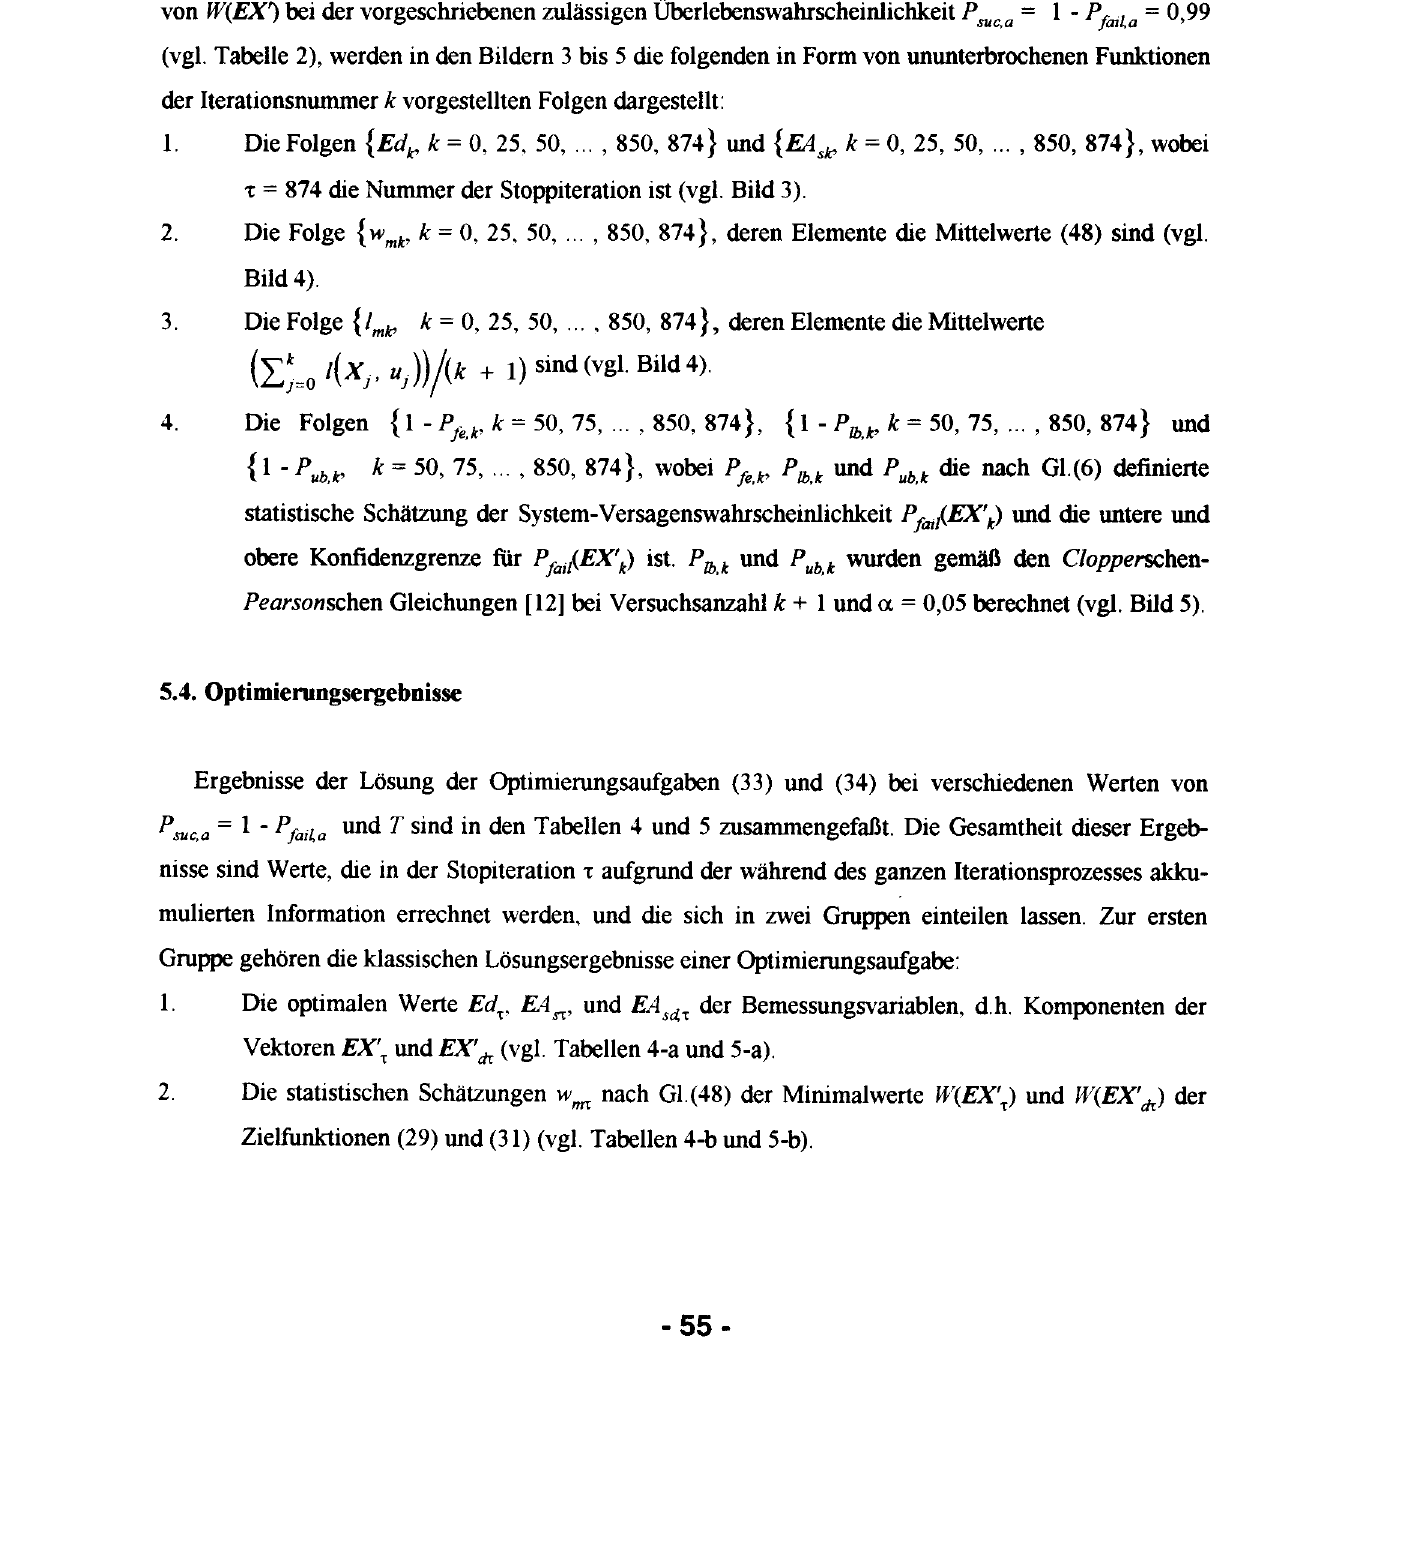
(vgl. Tabelle 2), werden in den Bildem 3 bis 5 die folgenden in Form von ununterbrochenen Funktionen der Iterationsnummer k vorgestellten Folgen